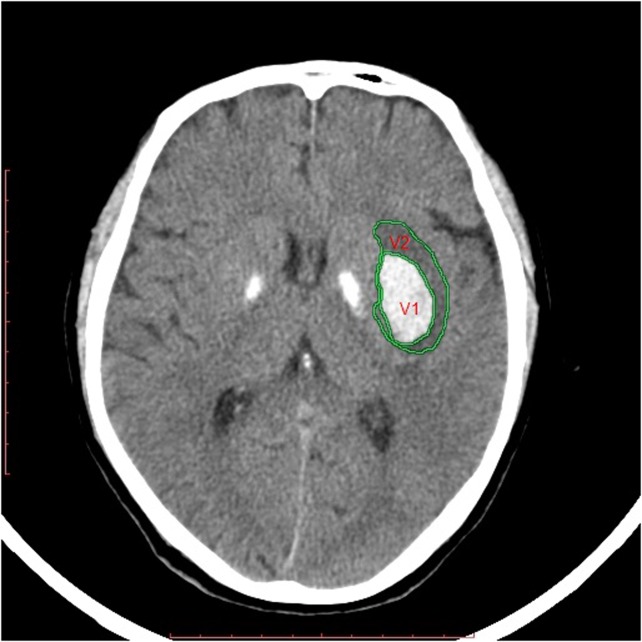
Depiction of the measurements of PHE and hematoma.(V1) Hyperdense hematoma regions and (V2) hypodense area surrounding hematoma for PHE. Volumes from all slices were summed: rPHE = V2/V1. PHE, perihematomal edema.